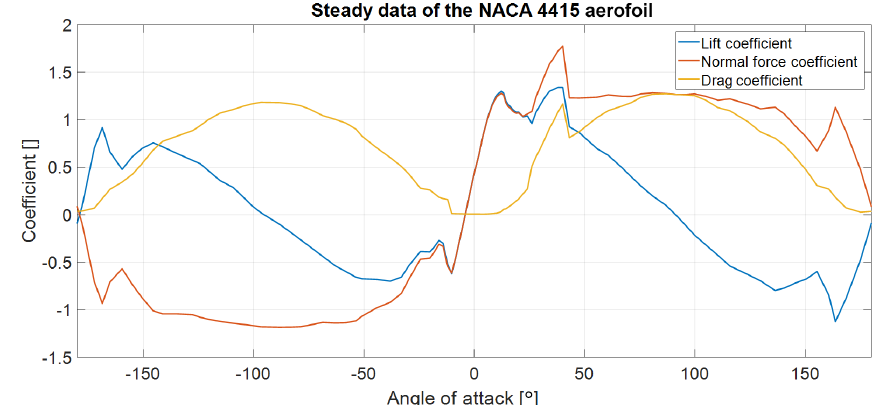
Figure 4. Steady polars of the NACA 4415 aerofoil.